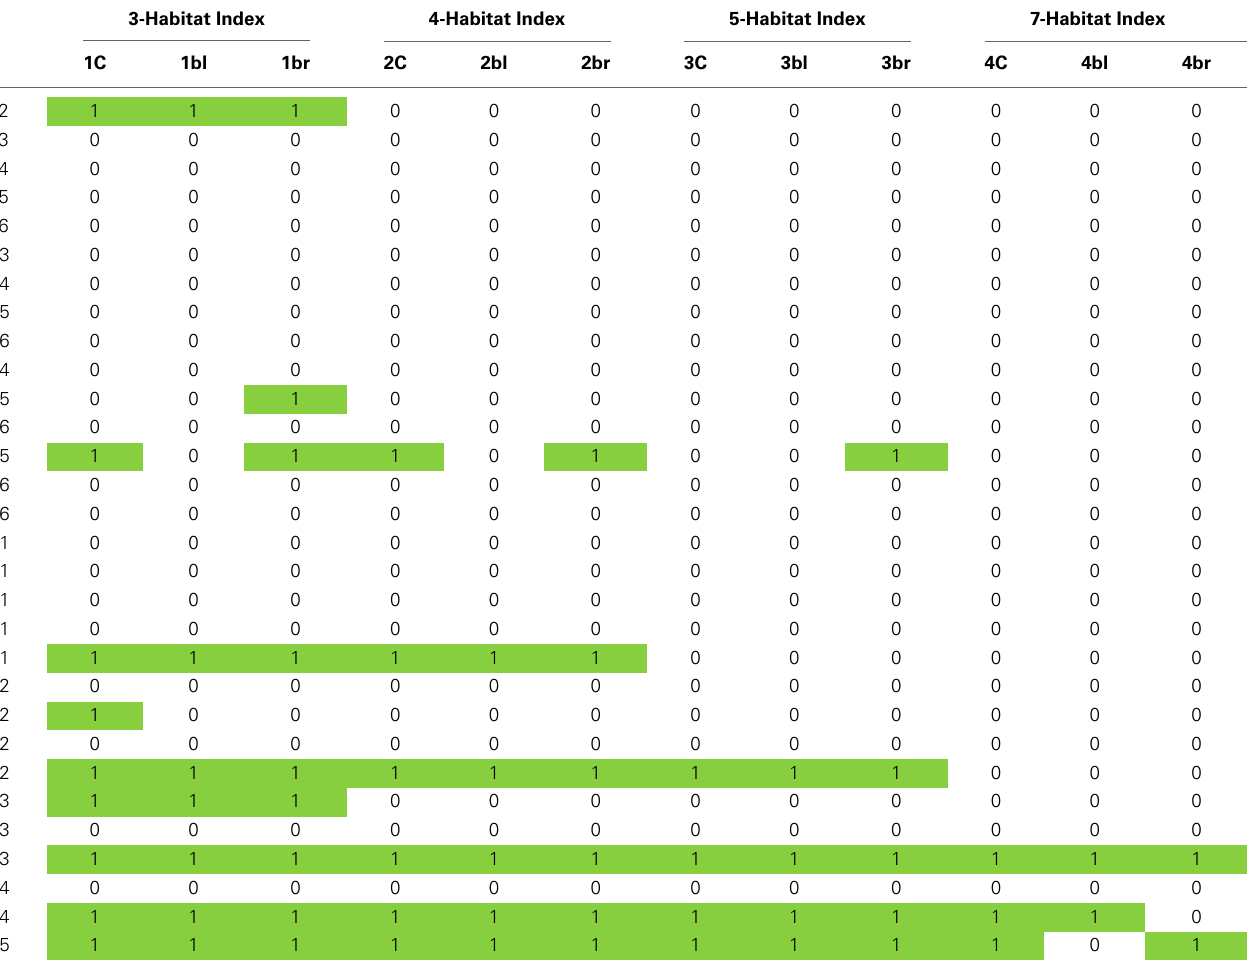
Table 1 | Boolean results of the 30 regional scale Normalized Difference Ratio ( NDR ) successfully responding to logical expressions associated with the 12 different coral reef